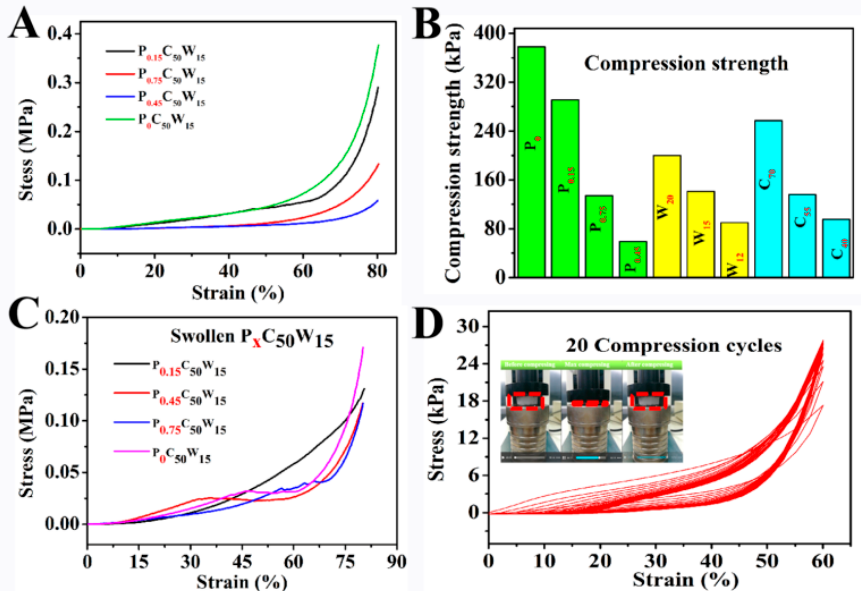
Figure 6. ( A )Compression stress–strain curves of polyHIPEs P x C 50 W 15 templated from C/W HIPEs containing 0, Figure 6. ( A ) Compression stress–strain curves of polyHIPEs P x C 50 W 15 templated from C / W 0.15, 0.45, and 0.75 g Ca-BDC respectively;( B ) compression strengths of polyHIPEsP x C 50 W 15 , P 0.45 C 50 W x , and HIPEs containing 0, 0.15, 0.45, and 0.75 g Ca-BDC respectively; ( B ) compression strengths of P 0.45 C x W 20 obtained from different amounts of Ca-BDC, water, and CO 2, respectively;( C )compression polyHIPEsP x C 50 W 15 , P 0.45 C 50 W x , and P 0.45 C x W 20 obtained from di ff erent amounts of Ca-BDC, water, stress–strain curves of swollen polyHIPEs P x C 50 W 15 templated from C/W HIPEs containing 0, 0.15, 0.45, and 0.75 and CO 2, respectively; ( C ) compression stress–strain curves of swollen polyHIPEs P x C 50 W 15 templated g Ca-BDC respectively;( D ) the 20 compression cycles of polyHIPEs P 0.45 C 70 W 20 . from C / W HIPEs containing 0, 0.15, 0.45, and 0.75 g Ca-BDC respectively; ( D ) the 20 compression cycles of polyHIPEs P 0.45 C 70 W 20